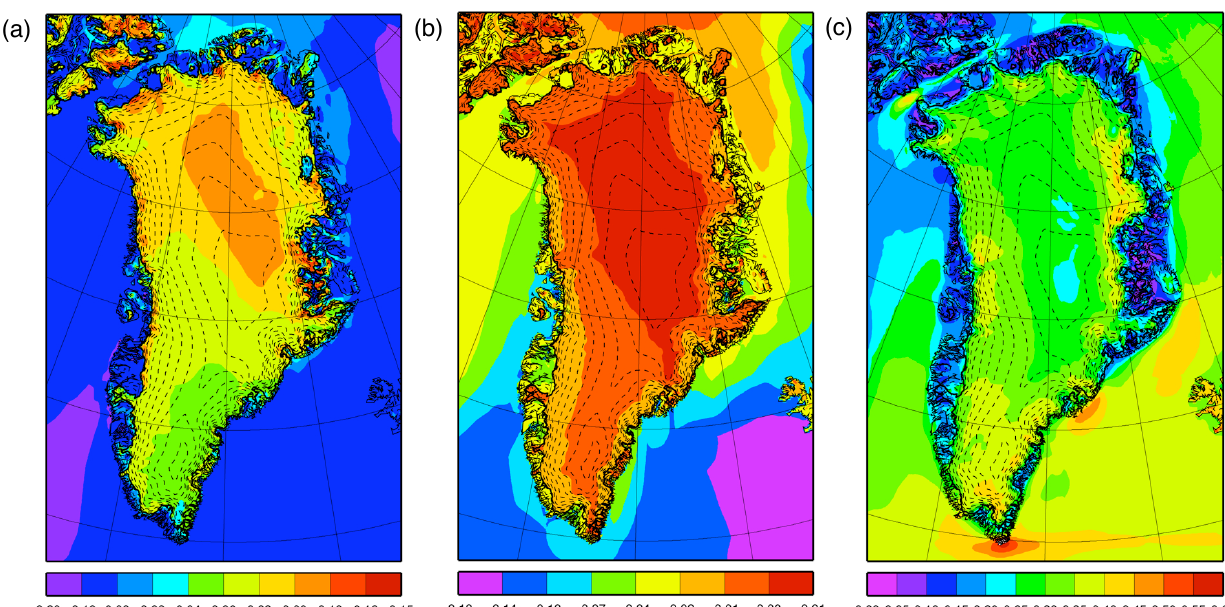
Fig. 12. Annual mean (a) turbulent temperature scale θ ∗ [K], (b) turbulent humidity scale q ∗ [gkg − 1 ], and (c) friction velocity u ∗ [ms − 1 ] over the period 1958–2008.